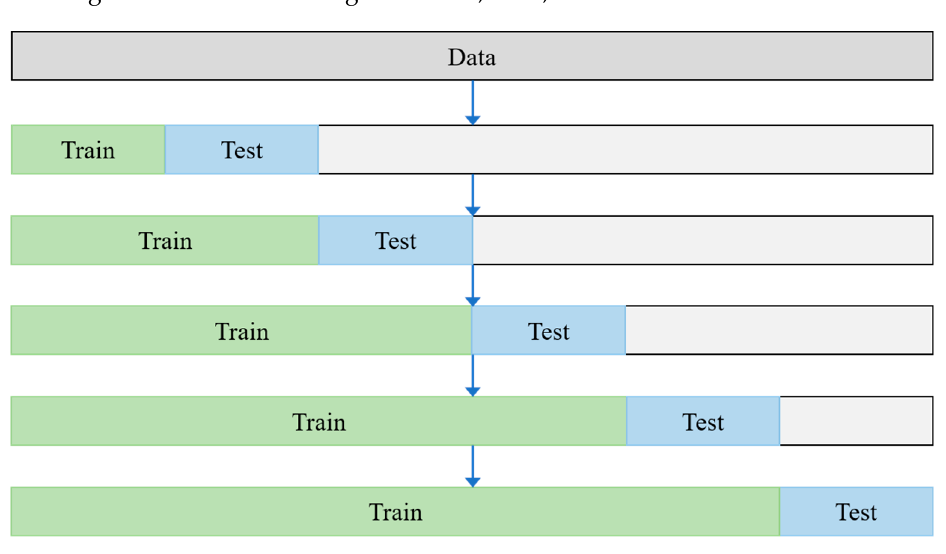
Figure 8. Framework for the time-series cross-validation. Table 12. The cross-validation result of forecasting using LSTM without decomposition.